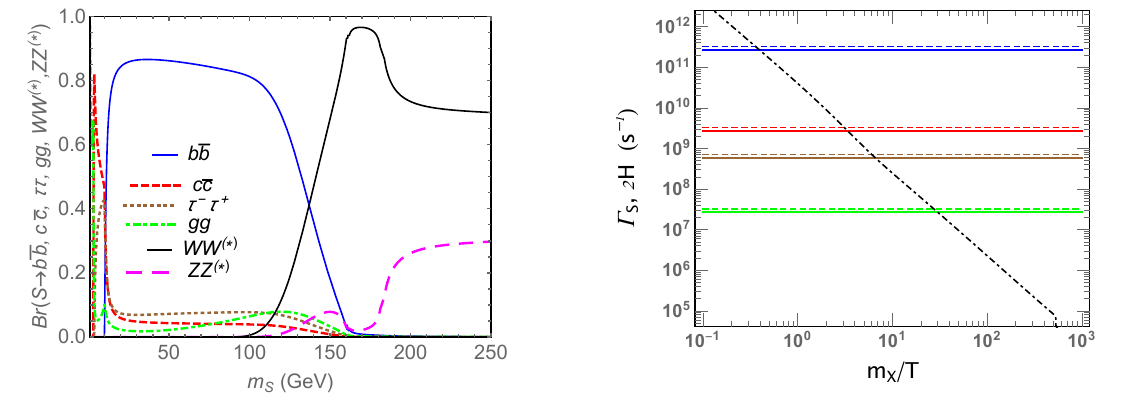
Figure 1 . Left panel: the main branching ratios of the hidden mediator S with m S < 250 GeV. Right panel: the S decay rate (total width), (cid:0) S , and twice of the Hubble rate, 2 H , as functions of m X =T , where T is the temperature of the bath. The horizontal lines from up to down with colors blue, red, brown, and green are the S decay rates corresponding to (cid:11) = 1 (cid:2) 10 (cid:0) 5 ; 1 (cid:2) 10 (cid:0) 6 ; 5 (cid:2) 10 (cid:0) 7 , and 1 (cid:2) 10 (cid:0) 7 , respectively, while the black dotdashed line stands for the Hubble rate. In this plot, us- ing m X =80 GeV, the solid and dashed lines correspond to m S = 0 : 8 m X and 0 : 99 m X , respectively. Q is the U (1) charge of (cid:8) . After spontaneous symmetry breaking, the Higgs (cid:8) S S dm